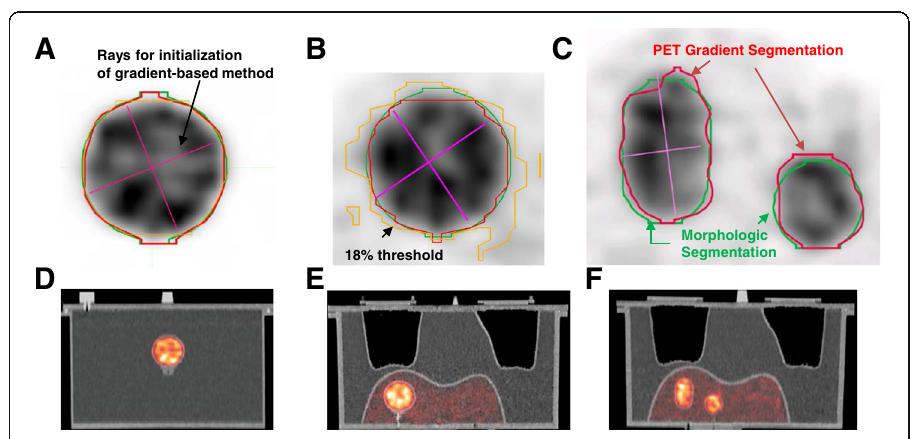
Fig. 1 90 Y PET (top) and fused PET/CT (bottom) corresponding to the phantom studies showing MS (green) and PS (red). Example rays from PETEdge tool are also shown. A threshold of 18% (orange) provided the best volume estimate (61.8 cc) to the MS in ( a ) (cold background), while the same 18% threshold overestimated the sphere volume (102.4 cc) in ( b) (warm background). A 32% threshold (not shown) gave the best volume estimate (61.7 cc) for the MS in ( b ). Segmentation overlays on the zoomed in PET component in ( a ),( b ),( c ) corresponding to the the fused PET/CT in ( d ), ( e ), and ( f ),